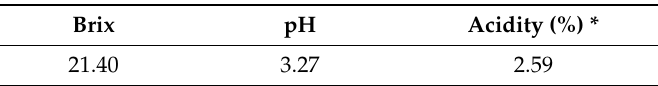
Table 3. Analysis of Cornus mas juice.